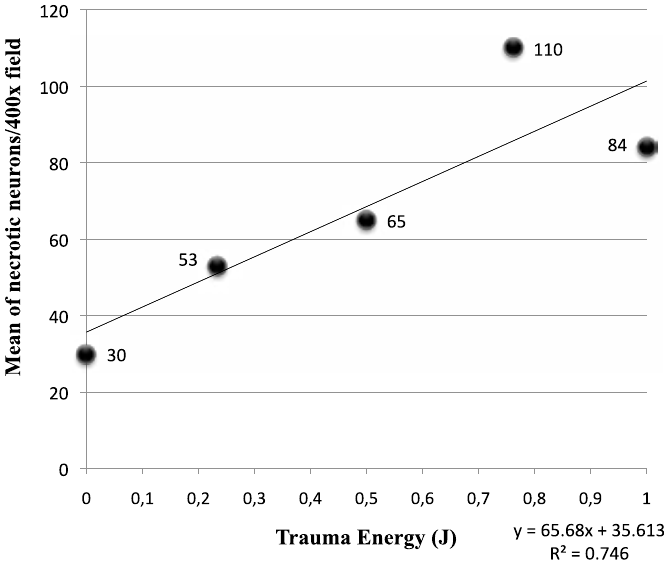
FIGURE 1 - This figure demonstrates strong positive correlation (r=0.86) between the trauma energy and the mean of necrotic neurons by high power Field in microscopic analysis.